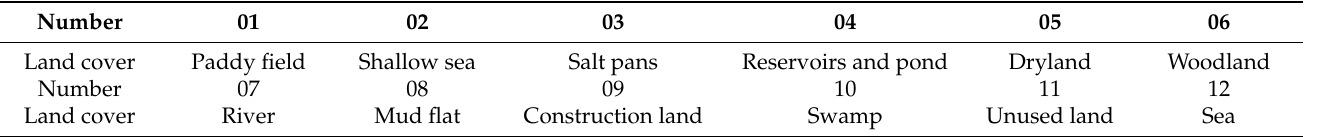
Table 8. The secondary classification coding of land cover and wetland types in the